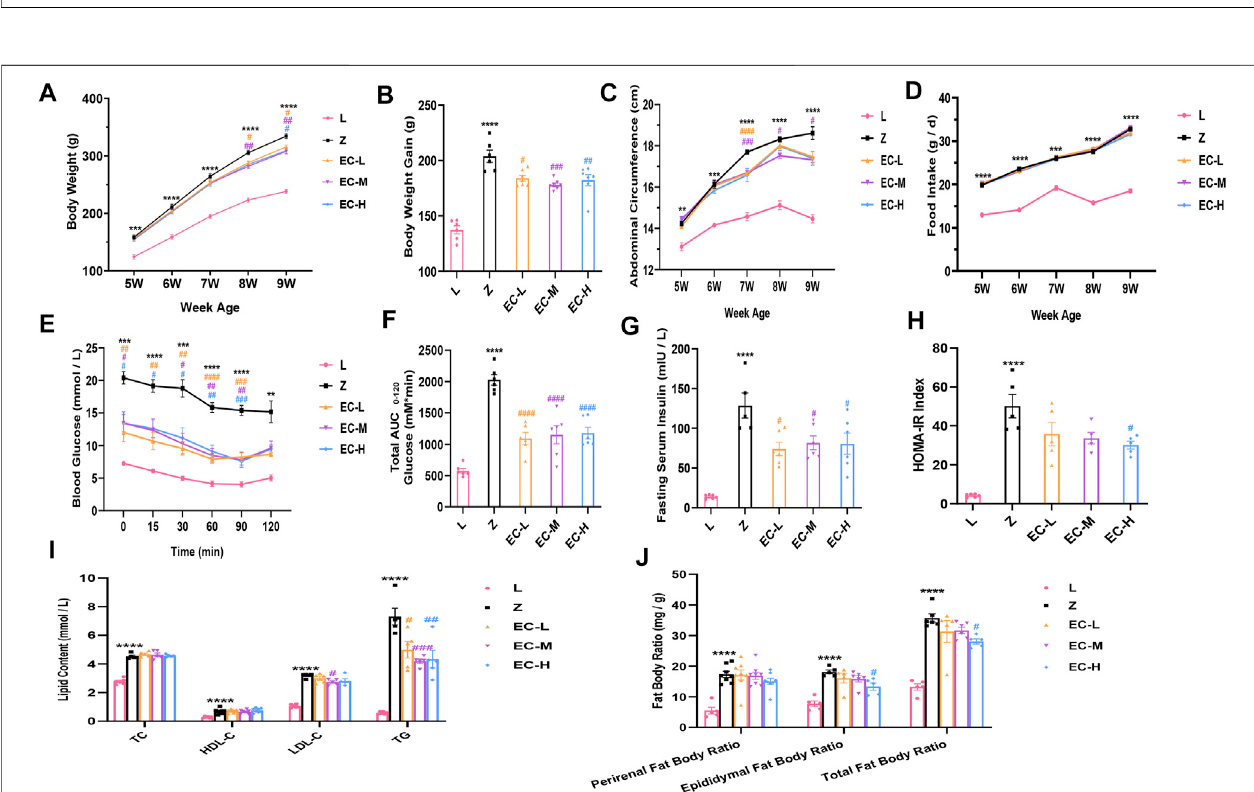
FIGURE 2 | ECD delayed the development of obesity in ZDF rats. (A) Weekly weight change. (B) Weight gain at 9 weeks of age. (C) Weekly abdominal circumference change. (D) Weekly food intake change. (E) Blood glucose levels during ITT. (F) AUC based on ITT data. (G) Fasting serum insulin levels. (H) HOMA-IR index. (I) Perirenal,epididymal,andtotalfatbodyratios. (J) SerumTC,HDL-C,LDL-C,andTGlevelsat9 weeksofage.Dataareexpressedasmeans ± SEM( n (cid:2) 5 – 8.Z vs.L, ** p < 0.01, *** p < 0.001, **** p < 0.0001;EC-L,EC-M,andEC-Hvs.Z, # p < 0.05, ## p < 0.01, ### p < 0.001, #### p < 0.0001).(A),(C),(D),and(E)wereanalyzedby two-way ANOVA, the rest were analyzed by one-way ANOVA.